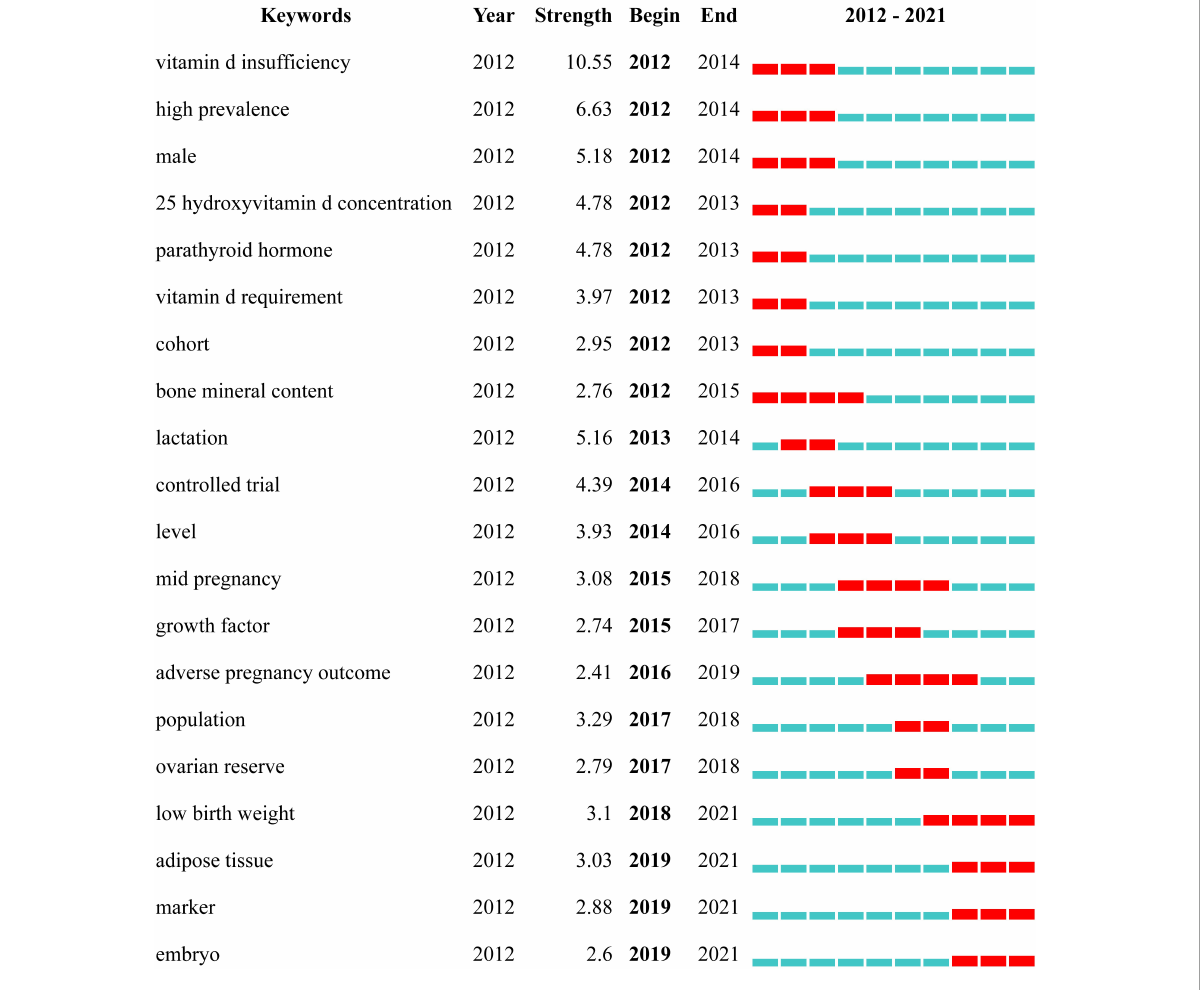
FIGURE6 Top 20 keywords with the strongest citation bursts based on